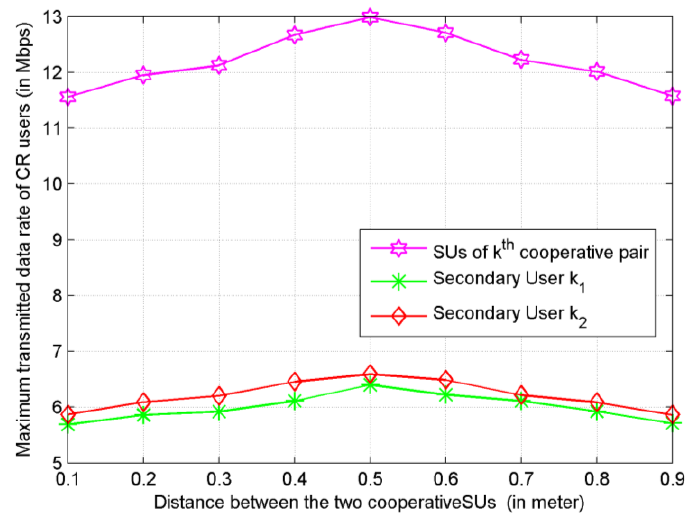
Figure 9. Maximum transmitted data rate versus distance between two cooperative